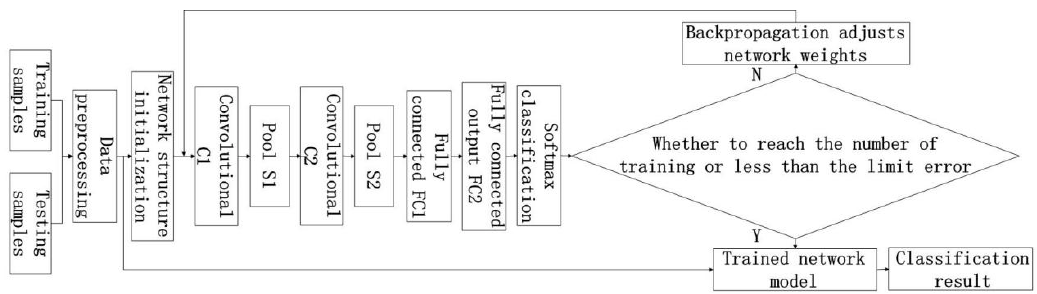
Figure 5. Classification flow chart of CNN hyperspectral remote sensing imaging (HSI).